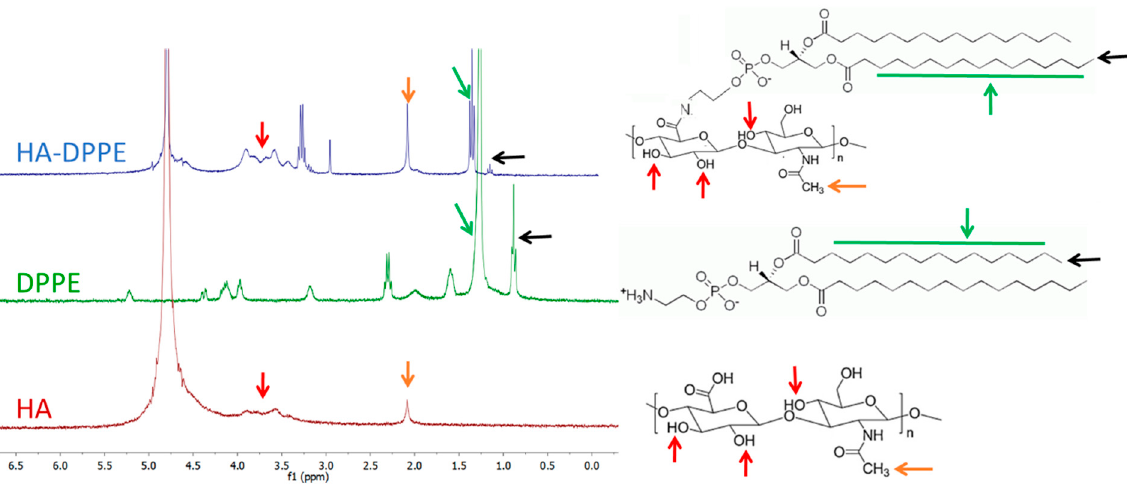
Figure 1. 1 H-NMR of DPPE, HA and HA-DPPE conjugates (left) and corresponding chemical structures (right). Methylene of DPPE group (black arrow). N-acetyl proton (methyl) of HA (orange arrow). Hydroxyl groups of HA (red arrow). The degree of substitution (DS), indicating the number of DPPE molecules grafted to HA, was 7.4%. It was calculated, as reported by Saadat et al. [19], by the ratio between the area of the peak corresponding to the methylene group of DPPE (1.2 ppm, green arrow) and the area of N-acetyl proton (methyl) of HA (1.9 ppm, orange arrow). The correct grafting of the DPPE to the HA backbone was also confirmed by FTIR spectroscopy (Figure 2); the spectrum of HA-DPPE (red line) shows peaks at 1744, 2850, and 2918, corresponding to the carbonyl and acyl chains of DPPE and a large peak at 3400 (black arrow) corresponding to the hydroxyl groups of HA.